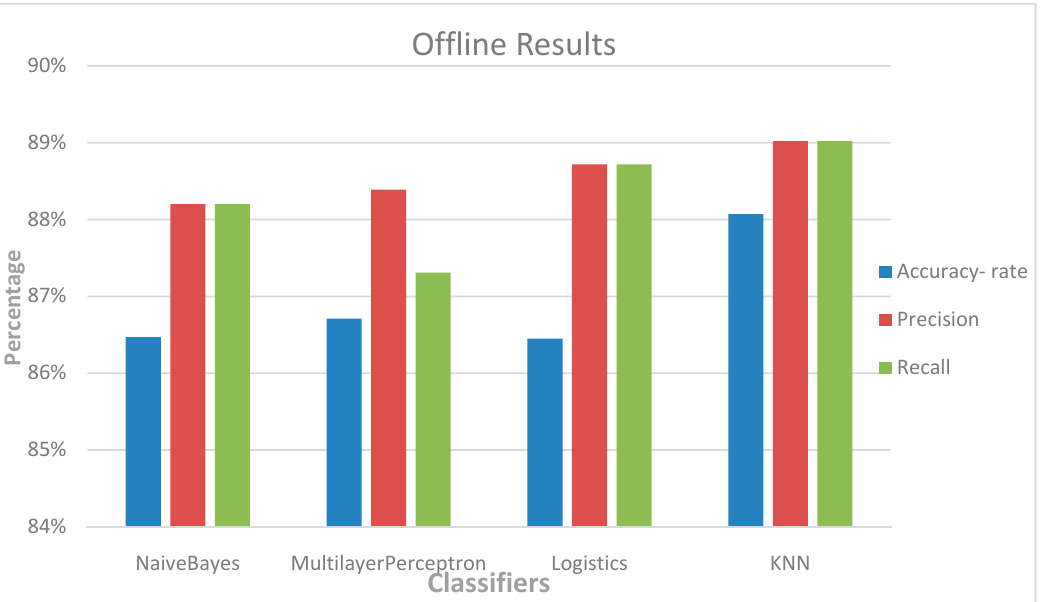
Figure 8. Online Analysis of the different classifiers. The difference between KNN and logistic regression, as seen in Figure 8, was very small for accuracy. The results of predictive modeling with and without variable selections were measured. Both results seemed to be good; however, statistical significance is not established for the logistic regression. Statistical significance was observed only in KNN and seemed to be sensitive to the variable selection method. 6.2. Monitoring of Air Pollutant The monitoring and forecasting of air pollutants are some of the major objectives of our proposed system. To achieve this objective, we utilized deep learning approaches for the good forecasting of future levels of a particular gas present in the air. Higher concentrations of CO cause severe health issues, as described in Table 2. Forecasting was done with the help of the LSTM model, along with a comparison with a univariant model, which was considered the base model. The dataset contained the hourly concentration of the different gases. Five days of observations of gas levels were used to create a window of size 120 (24 × 5) to train the model.